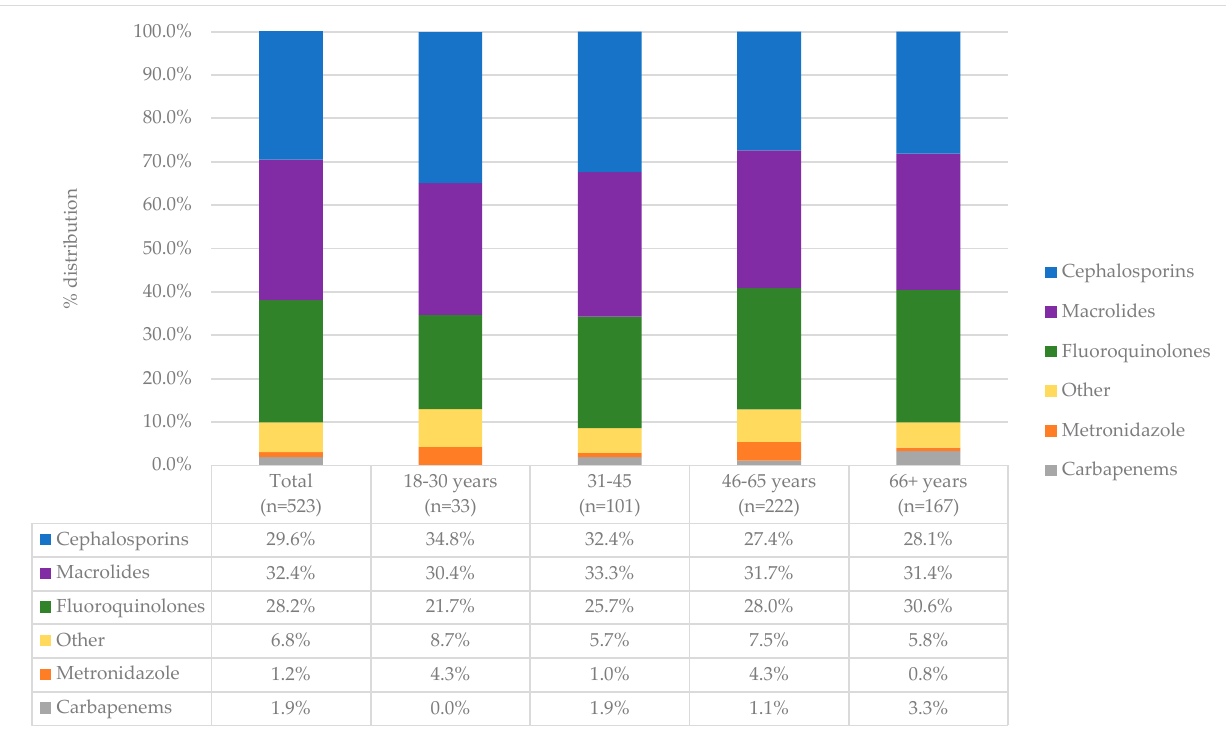
Figure 2. Pre-admission profile of antibiotics used across major age groups . Various patient characteristics at admission were analysed in relation to prior antibi- otic use. Associations with a longer duration of illness at admission (8.8 ± 5.3 vs. 5.7 ± 3.7, p < 0.001), a more frequent use for oxygen therapy upon admission (27.6% vs. 16.0%, p =